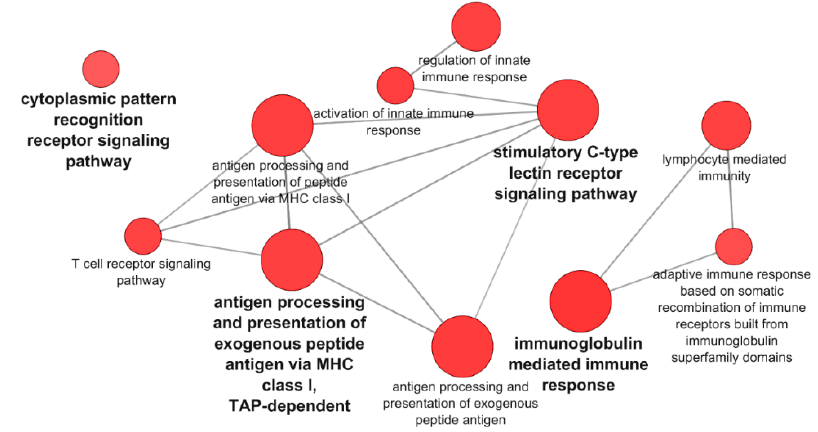
Figure 3. Comparative overview of DEGs shared by HK-PBCs and PB-RBCs. ( A ) Venn diagram of DEGs in RBCs from each tissue. The middle region shows genes expressed in RBCs from both tissues. ( B ) Clustering of gene expression of common DEGs in HK-RBCs and PB-RBCs was performed using ClustVis. The dataset was inserted into matrix category. Parameters for clusterization included no data transformation and no row scaling, and the principal component analysis (PCA) method used was singular value decomposition (SVD) with imputation. Red indicates higher expression and blue represents lower expression. ( C ) PPI networks of the DEGs shared between PB-RBCs and HK-RBCs from VHSV-challenged rainbow trout identified with GO Immune System Process terms and constructed using STRING software ( p -value < 10 − 16 ). Nodes represent proteins, while edges denote interaction between two proteins. Different line colors represent the types of evidence used in predicting the associations: Gene fusion (red), gene neighborhood (green), co-expression (black), gene co-occurrence (blue), experimentally determined (purple), from curated databases (teal), text-mining (yellow), or protein homology (lilac). Red nodes denote proteins implicated in the type I interferon signaling pathway (GO:0060337) and blue nodes denote proteins implicated in viral process (GO:0016032). ( D ) Expression of interferon-stimulated genes mx1-3 and ifit5 in PB-RBCs from VHSV-challenged rainbow trout (red bars) compared to mock-challenged (gray bars) as control at 2 dpc. Data represent mean ± SD ( n = 6). A Mann–Whitney test was performed to test statistical significance between PB-RBCs from both groups. Asterisks denote statistical significance. ** p -value < 0.01.